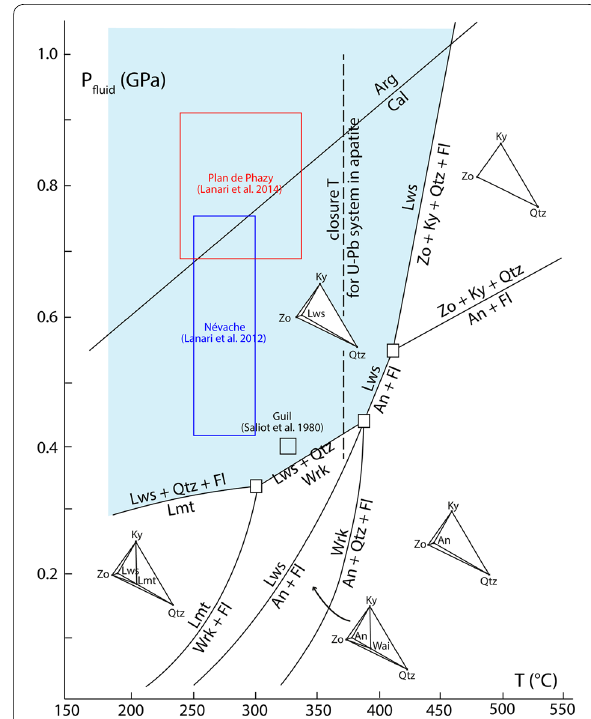
Fig. 10 Estimated P–T conditions for the lawsonite-bearing veins in the Guil valley (Saliot et al. 1980), compared to other estimates for external part of the Briançonais Zone, namely the Clarée valley (Lanari et al. 2012) and Plan de Phazy (Lanari et al. 2014). The stability field of lawsonite quartz fluid is shown in blue, according to the + + experimental data of Liou (1971). The lowest closure T of the U–Pb system in apatite (c. 370 °C) is also indicated (Cochrane et al. 2014)